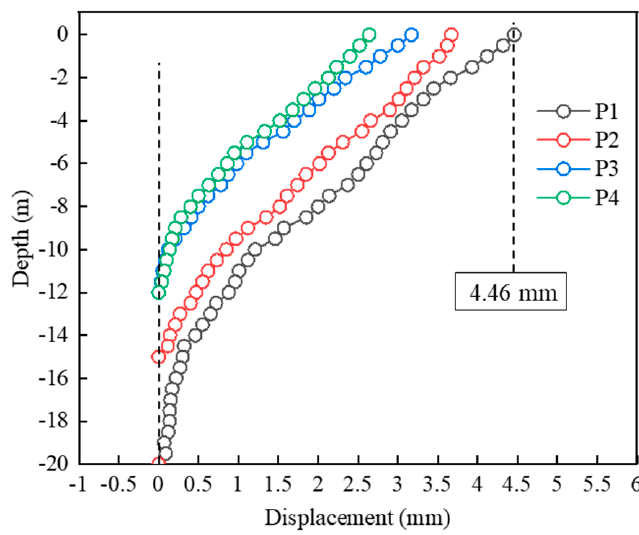
Figure 13. Variation curve of horizontal displacement at various depths.